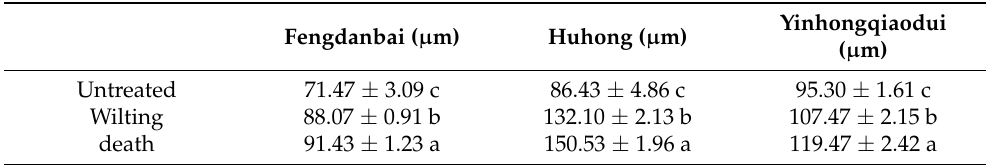
Table 2. The changes in the leaf thickness of Fengdanbai’ ‘Yinhongqiaodui’ and ‘Huhong peony cultivars under high-temperature stress.